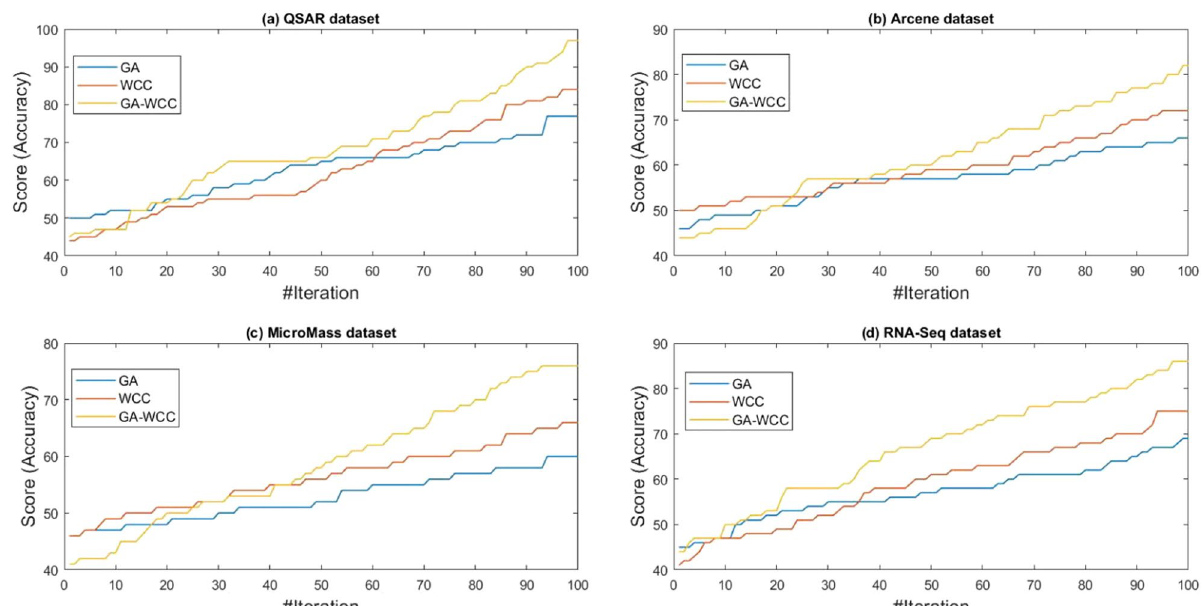
Figure 13. Convergence of the GA, WCC, and GA-WCC algorithms on the ( a ) QSAR, ( b ) Arcene, ( c ) MicroMass, and ( d ) RNA-Seq datasets. In the early stages of the iterations, the algorithms present a similar behavior. However, after elapsing more times, the WCC algorithm shows better performance than the GA, and the proposed method exhibits proper convergence behavior than the WCC